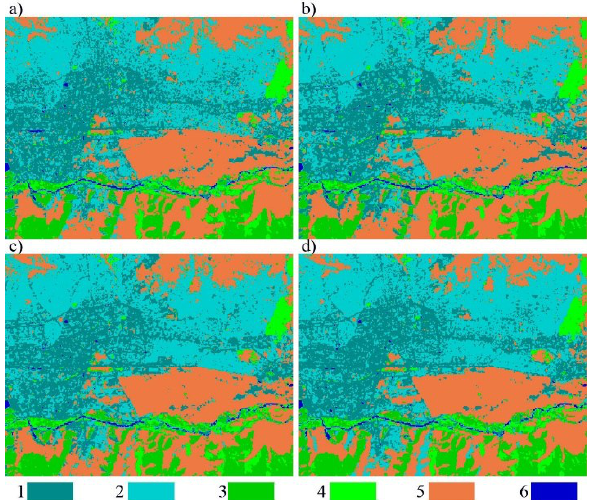
Figure 3. Comparison of the standard classification results for the selected classes (1-builtup area; 2-ger area; 3-forest; 4-grass; 5- soil; 6-water). Classified images (a) using Landsat 8 bands, (b) Table 2. The separabilities measured by Jeffries–Matusita using bands 4,5 and 6 of the Landsat 8 image, (c) using PCs, (d) distance using multisource